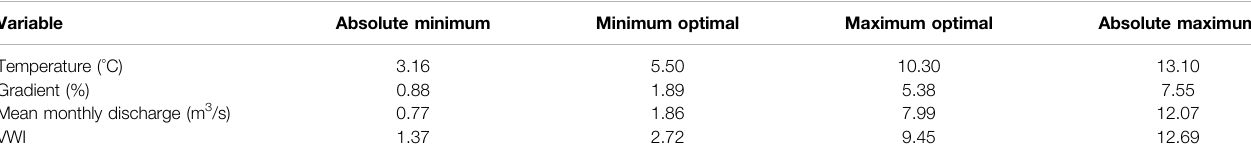
TABLE 2 | Response means of absolute minimum and maximum, and minimum and maximum optimal values for each variable from the second expert opinion second survey. Variable Absolute